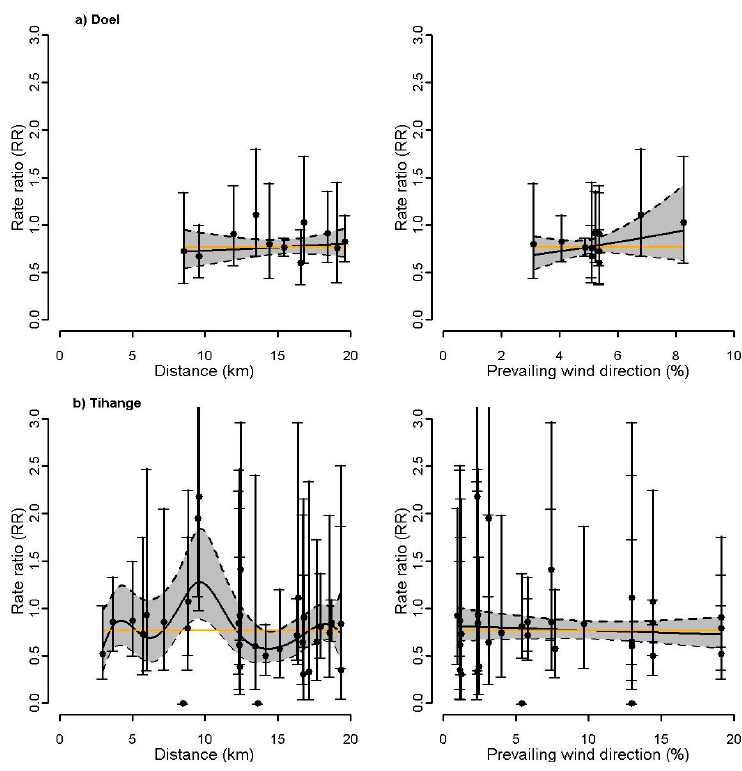
Figure 3. ( a ) Doel; ( b ) Tihange: Rate ratios (RR) and 95% confidence interval (CI) (gray area) of thyroid cancer incidence within the 20 km proximity areas as a smooth function of 1: residential proximity to the nuclear site and 2: prevailing wind directions. The orange line represents the constant RR. The dots represent the commune-specific RRs with their 95% CI. Table 2. Results ( p -values) of the Bithell’s Linear Risk Score test (LRS), Bithell’s Linear Risk Score test with corresponding ranks (LRS rank) and Stone test for measures of surrogate exposure in the vicinity of the nuclear sites ( ≤ 20 km).